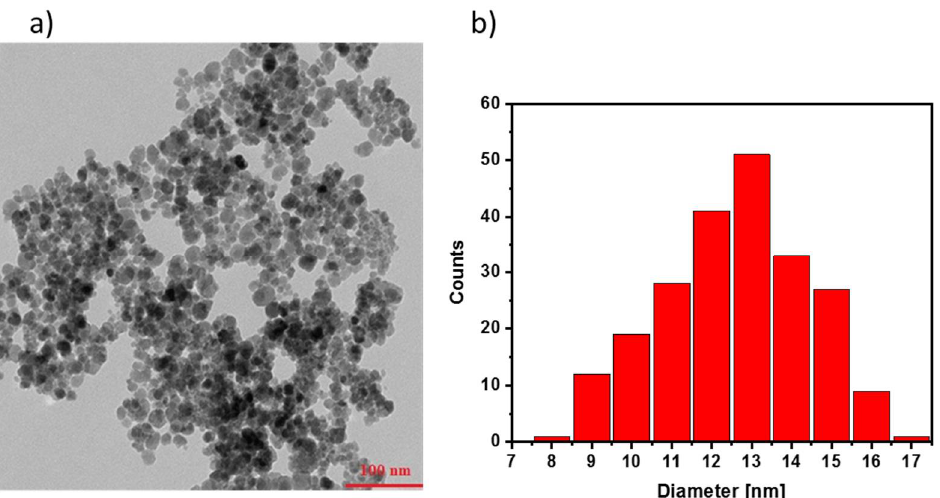
Figure 1. TEM images of IONP@CA ( a ), and size distribution graph (histogram) ( b ) (scale bar = 100 nm).